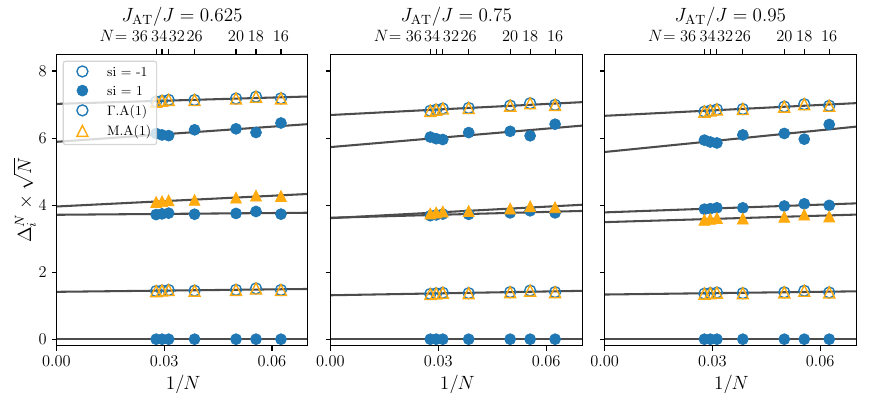
Figure 13: Finite-size extrapolations of the scaled energy gaps of the AT-TFI model / J > 0. We perform linear expansions of the scaled finite-size energy gaps at J (cid:112) AT ∆ N × N (symbols) in 1 / N (grey lines) to obtain the corresponding CTESs for i N → ∞ (i.e. 1 / N = 0). The CTESs are also shown in Fig. 5 in the main text and identified to belong to the XY / O(2) universality